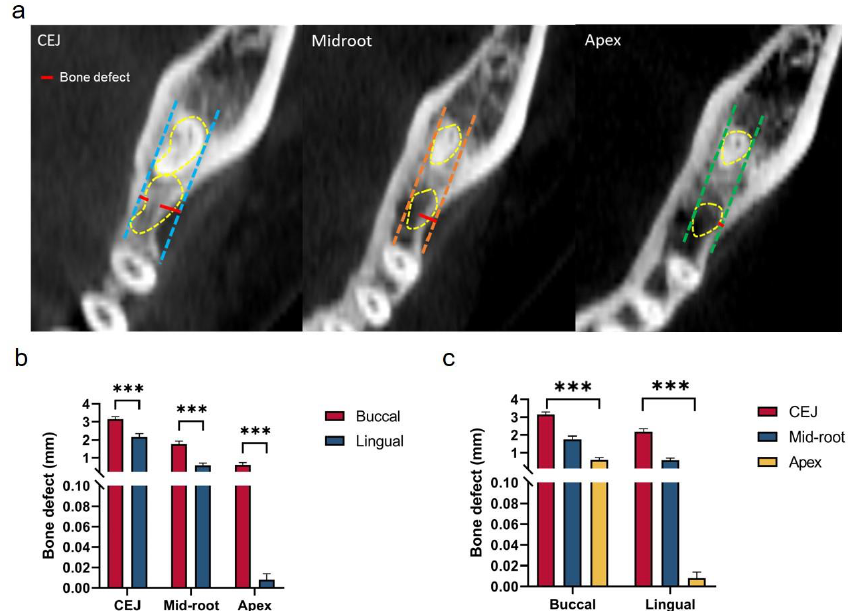
Figure 8. ( a ) Measurements of buccal and lingual bone defects at CEJ, mid-root, and apex levels. ( b ) Comparisons of the buccal and lingual bone defects. ( c ) Comparisons of the bone defects at CEJ, mid-root, and apex levels. *** indicates p < 0.001.